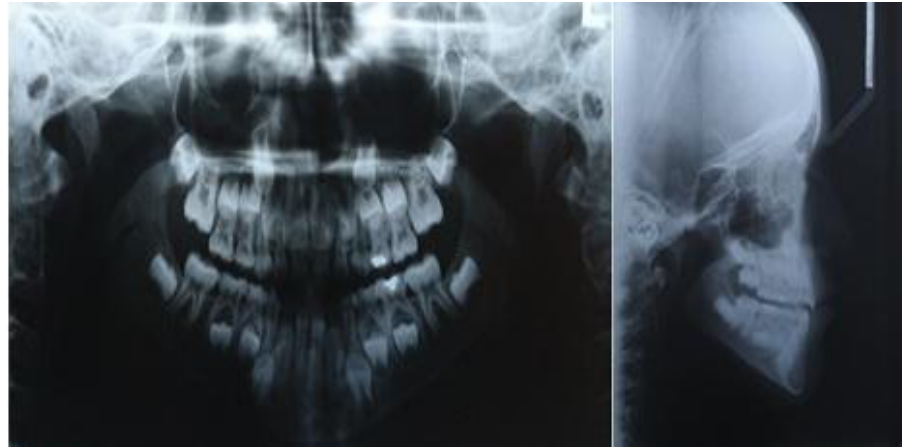
Figure 2. The initial panoramic and cephalogram radiographs of the patient at the age of